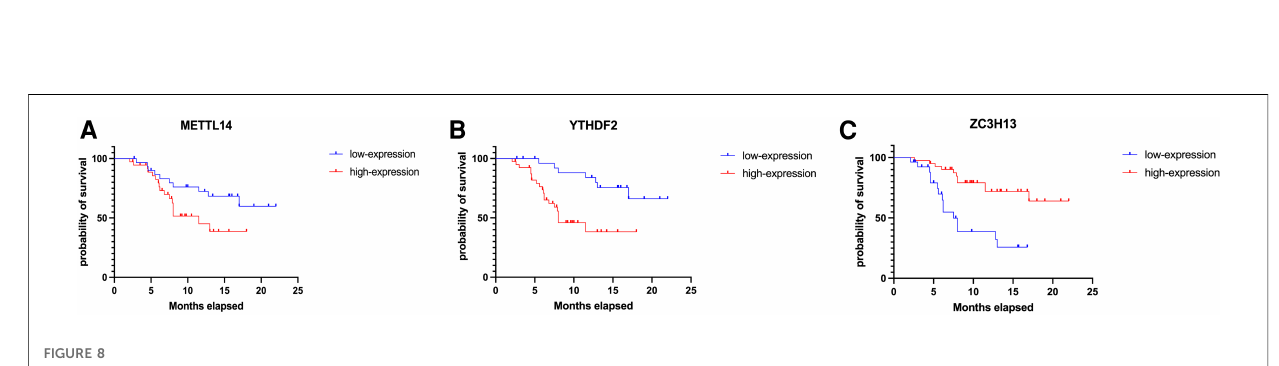
FIGURE 7 Contrast of paracancerous tissue and tumor tissue immunohistochemical staining. Contrast of paracancerous tissue and tumor tissue immunohistochemical staining (×200) ( A – C ). Intensity comparison of METTL14, YTHDF2, ZC3H13 staining in cancer tissue ( A,B ). Scale bar=50 µm.